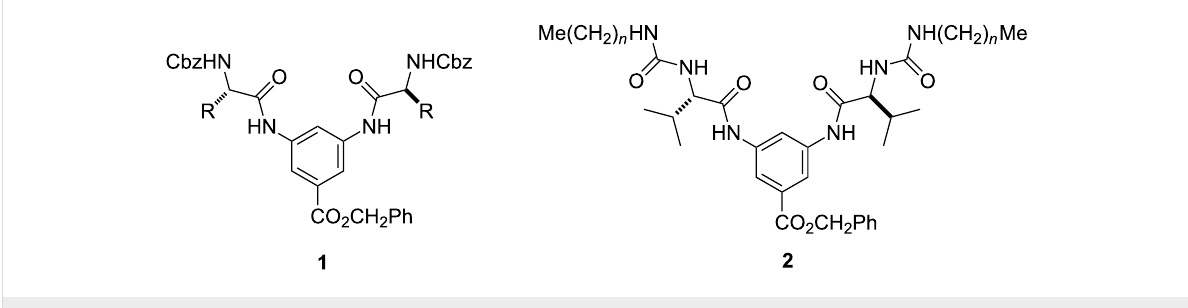
Figure 1: Amino acid based organogelators 1 and 2 .